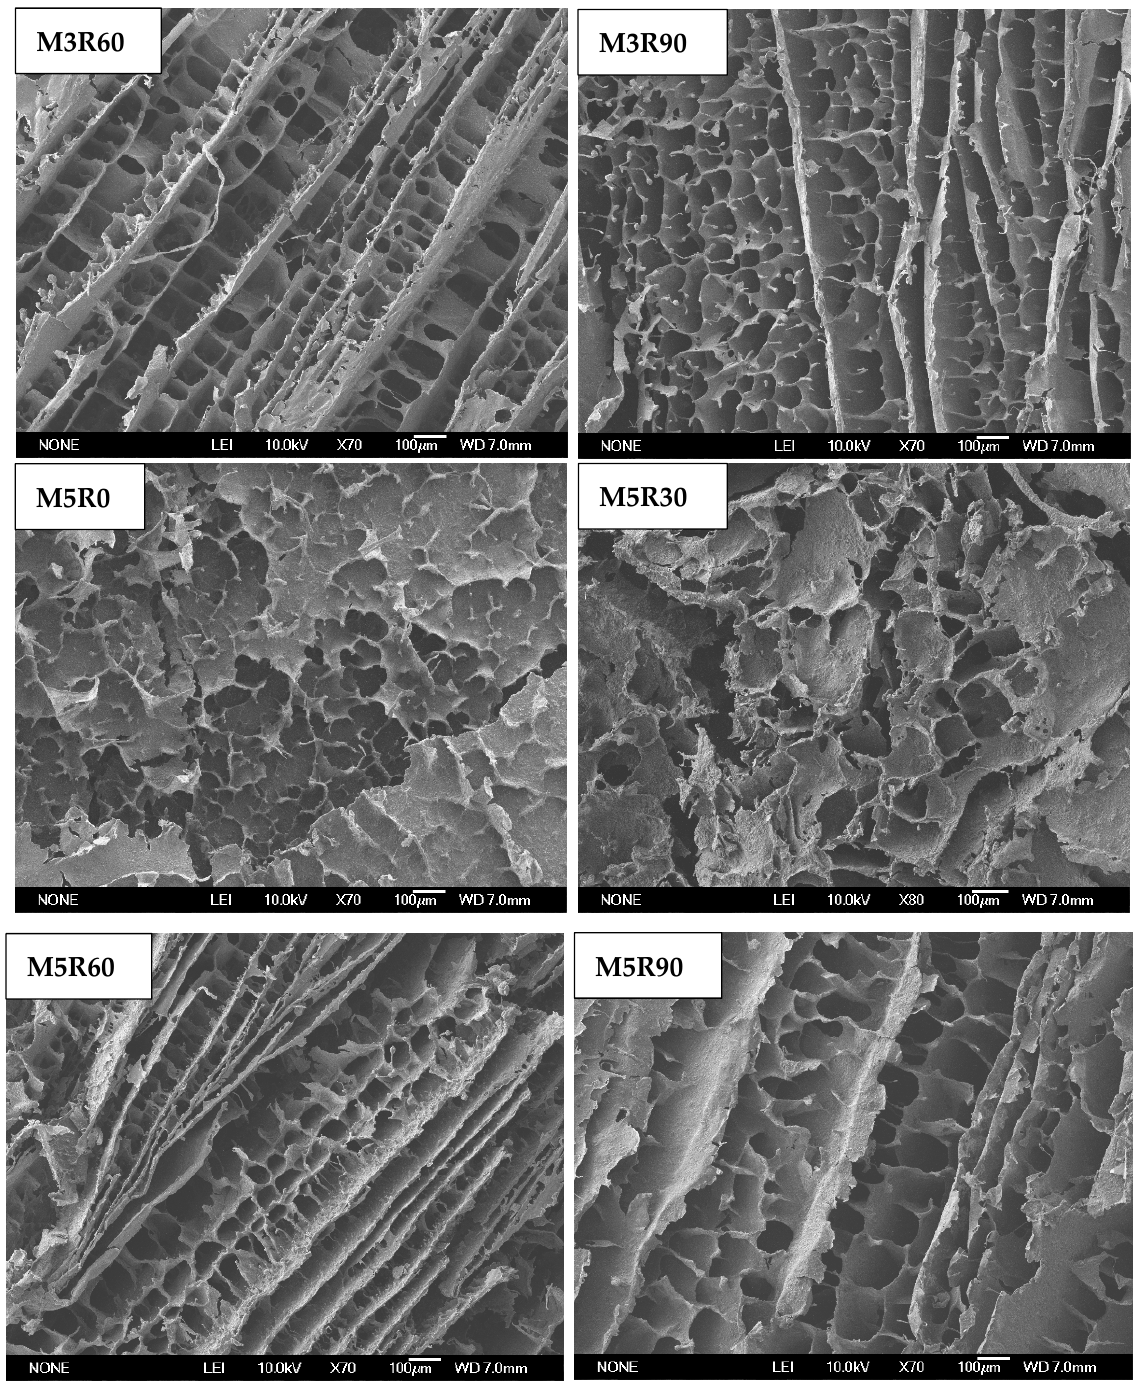
Figure 5. SEM images of the microstructure of the GMP. Flour: wheat flour without mixing or resting. M3R0–M3R90: mixing for 3 min and resting for 0, 30, 60, and 90 min, respectively. M5R0–M5R90: mixing for 5 min and resting for 0, 30, 60, and 90 min, respectively.